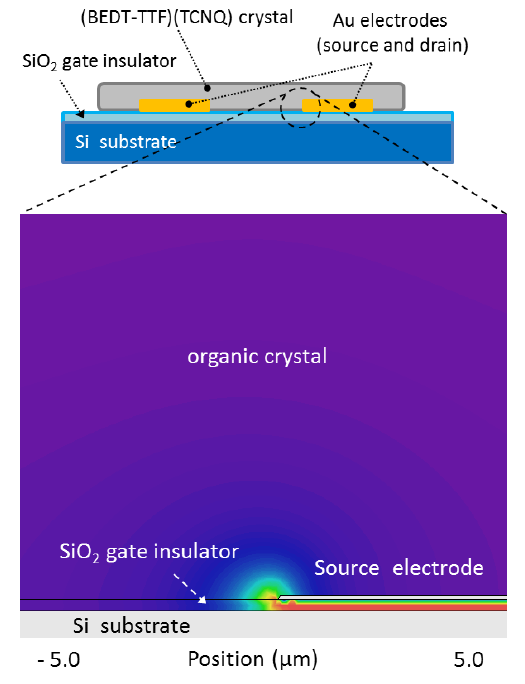
Calculated electrical flux density distribution in the FET sample with the source and gate voltage of 0 and 30 V, respectively. The electric flux density